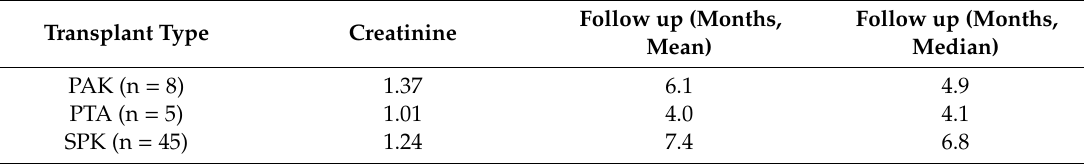
Figure 2. Graft survival and troponin elevation after pancreas transplantation. Graft survival was worse for patients who also experienced post-transplantation troponin elevation ( p = 0.025). Table 3. Serum creatinine after pancreas